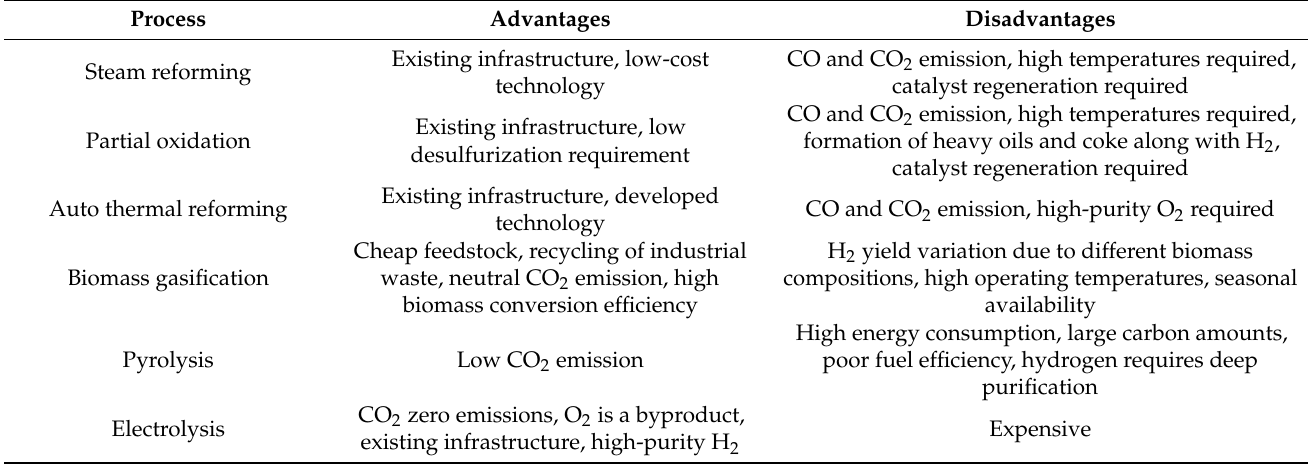
Table 5. Comparison of the advantages and disadvantages of the main hydrogen production pro-